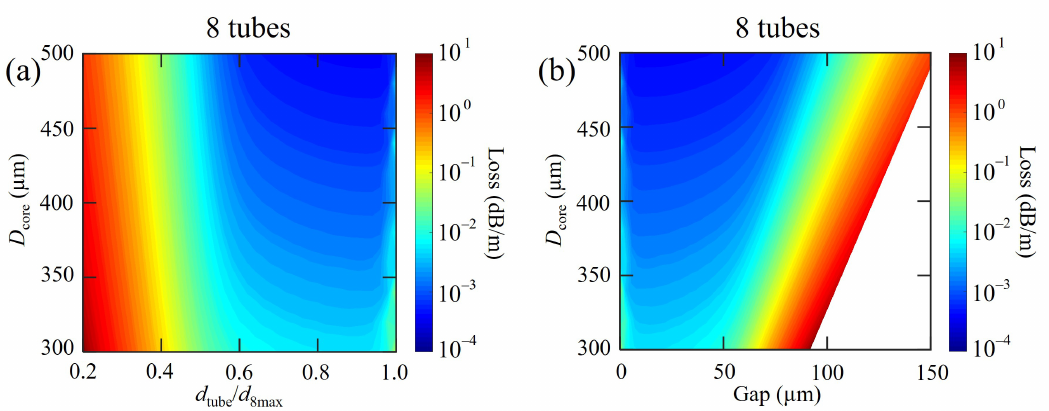
Figure 4. ( a ) Contour plot of loss as a function of core diameter and normalized tube diameter. ( b ) Contour plot of loss as a function of the core diameter and gap. The number of cladding tubes is